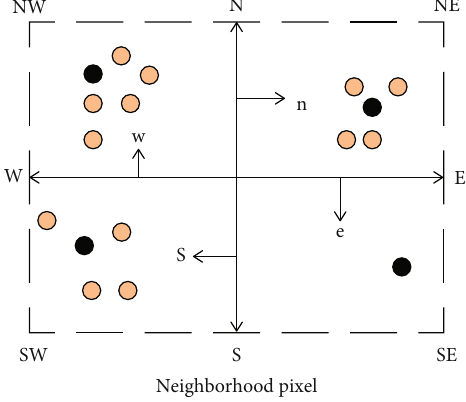
Figure 6: Process diagram of pixel increase in adjacent area.